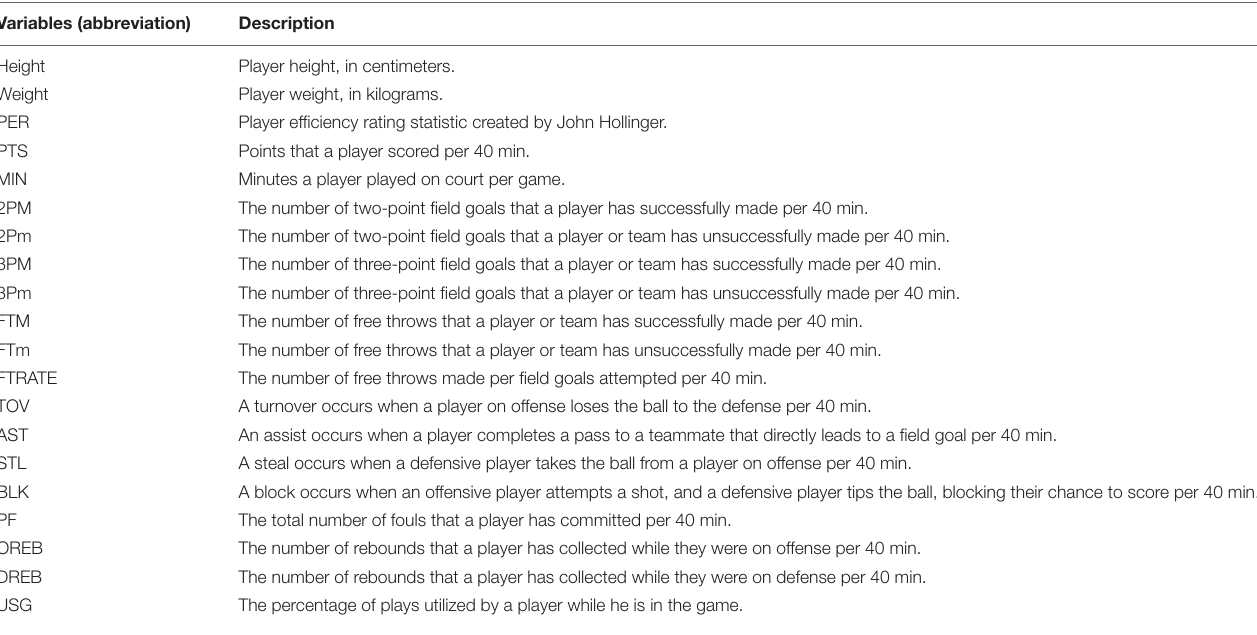
TABLE 1 | Selected game related variables